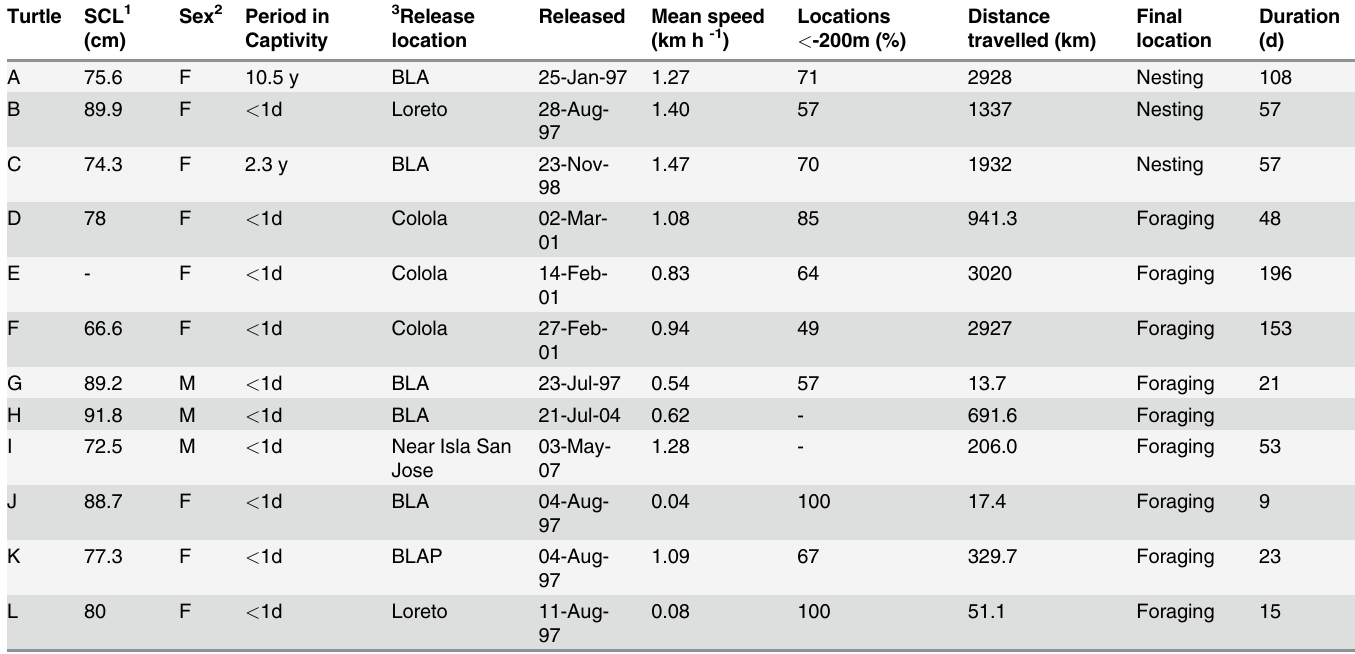
Table 1. Summary data of morphometrics and tracking details of 12 East Paci fi c green turtles. Turtle SCL